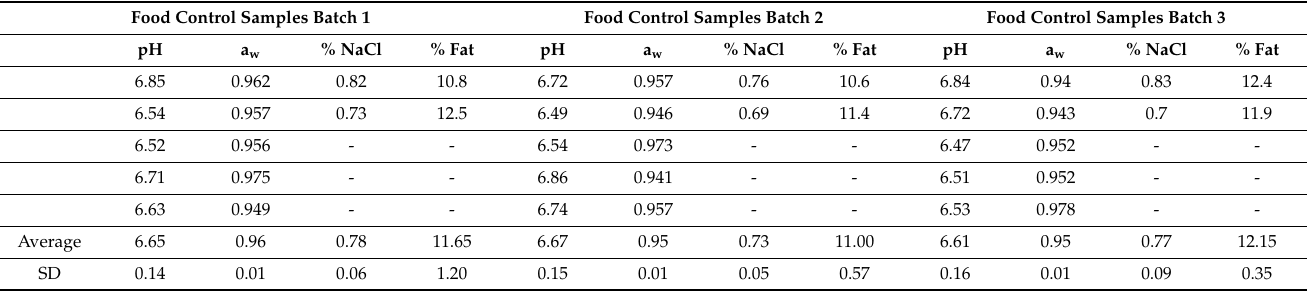
Table 2. Physico-chemical characteristics of the five food control samples of each batch at “Day 0”. Food Control Samples Batch